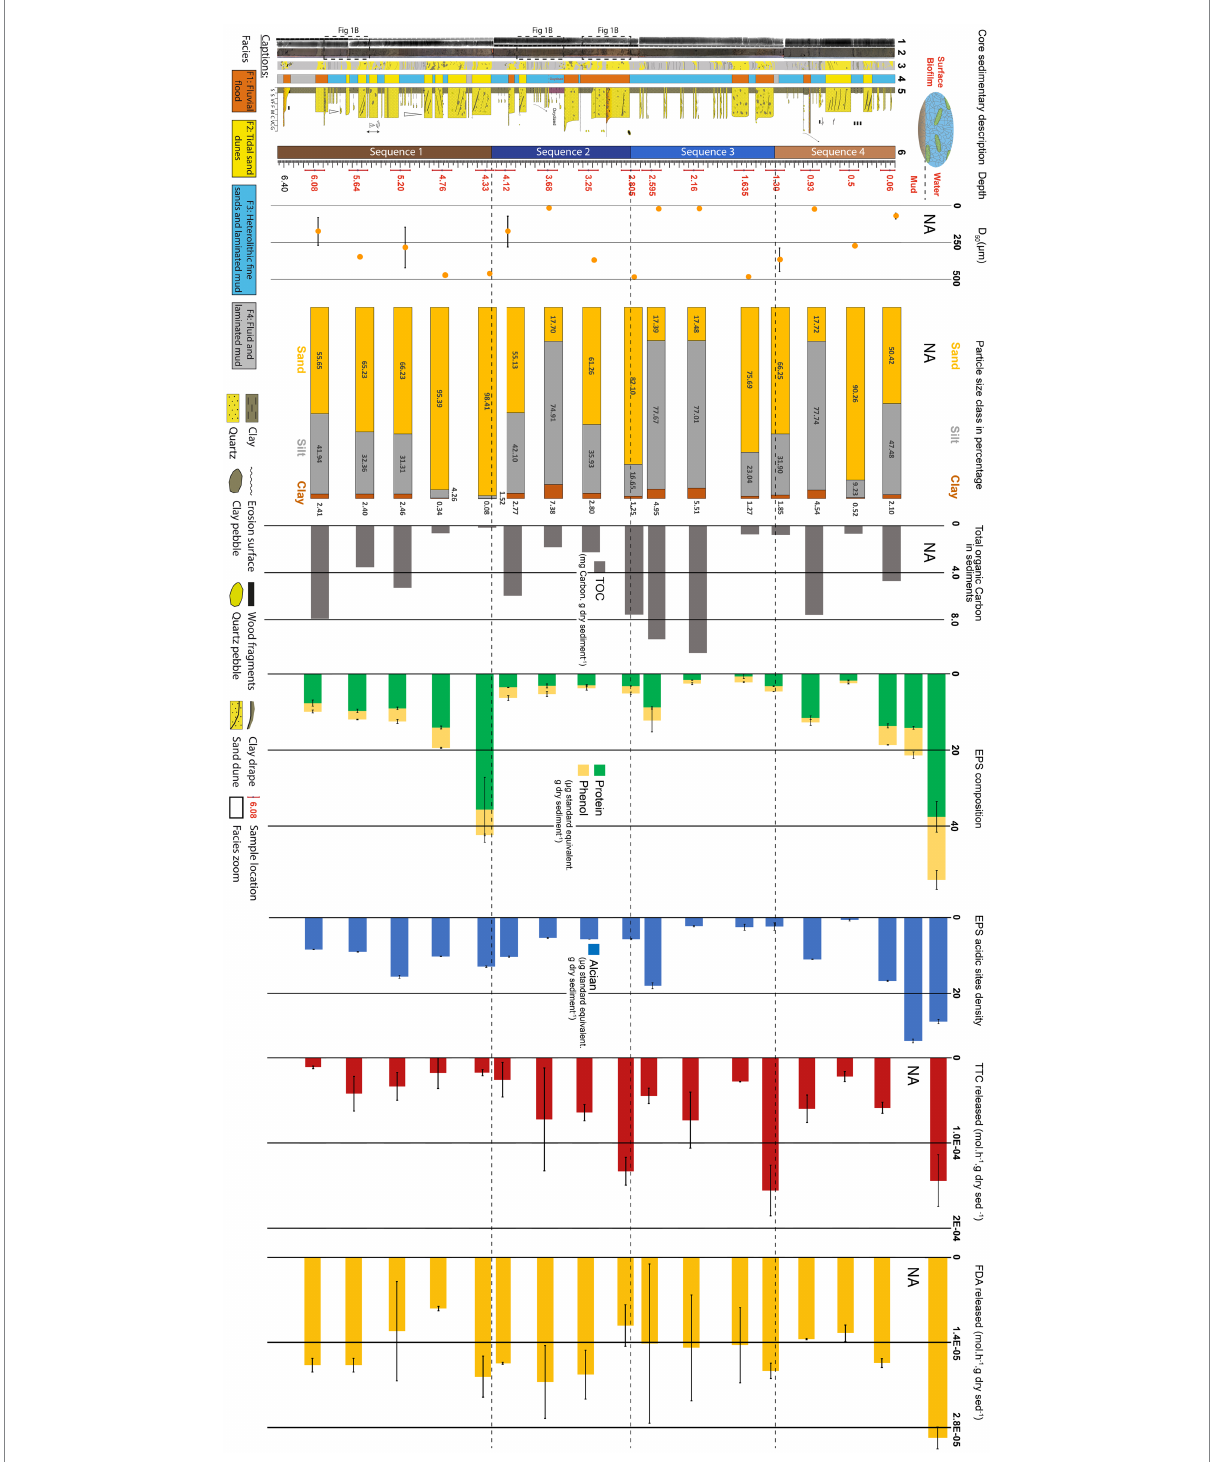
FIGURE 2 Evolution of exopolymeric substances (EPSs) and sediment properties with depth along the 6 m-long BXN Long Core (see location Figure 1). First column to the left: sedimentary description. (1) X -Ray image (SCOPIX); (2) core photographs; (3) sketch; (4) facies; (5) sedimentary log, and (6) sedimentary sequences. Sample depths are written in red. Second column: median grain size (D 50 ; yellow dots). Third column: particle size class percentage: clay (brown), silt (gray), and sand (yellow). Fourth column: Sugar and protein concentrations: phenol-sulfuric assay (yellow) and protein assay (green). Fifth column: EPS acidic site density measured with the Alcian Blue assay (blue). Sixth column: total organic carbon (TOC) in the sediment (black). Seventh column: rate of metabolic activity using TTC reduction as a proxy (red). Height column: rate of enzymatic activity using hydrolyzation of FDA as a proxy